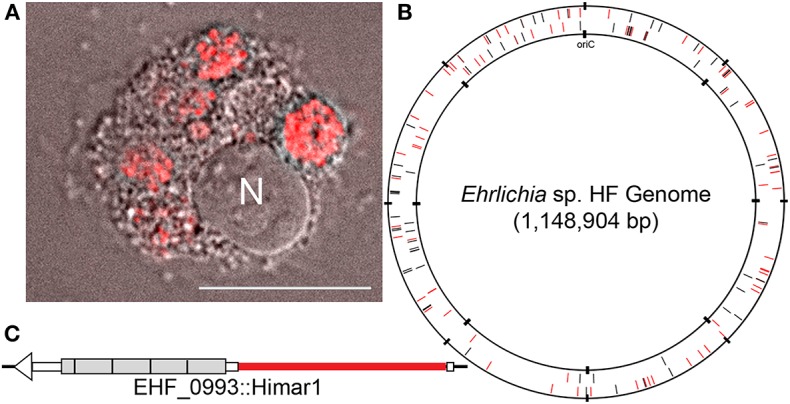
HF mutant and genomic map of the HF strain, showing transposon insertion sites. (A) HF mutant H53 expressing mCherry fluorescence in DH82 cells. N, nucleus. mCherry fluorescence/Differential Interference Microscopy. DeltaVision deconvolution microscopy, Scale bar, 10 μm. (B)
Ehrlichia sp. HF chromosomal map showing transposon insertion sites. All mutant bacteria containing the Himar insertions were recovered from DH82 cells by the selection of spectinomycin and streptomycin antibiotics. Black lines represent intragenic insertions and red lines represent intergenic insertions. (C) HF mutant H60E (EHF_0993::Himar1). Insertion site is near 5′-end of the gene encoding TRP120 at upstream of the 4 1/4 of the 300-bp tandem repeats (shown in gray boxes) in TRP120, likely disrupting this protein's expression or function.